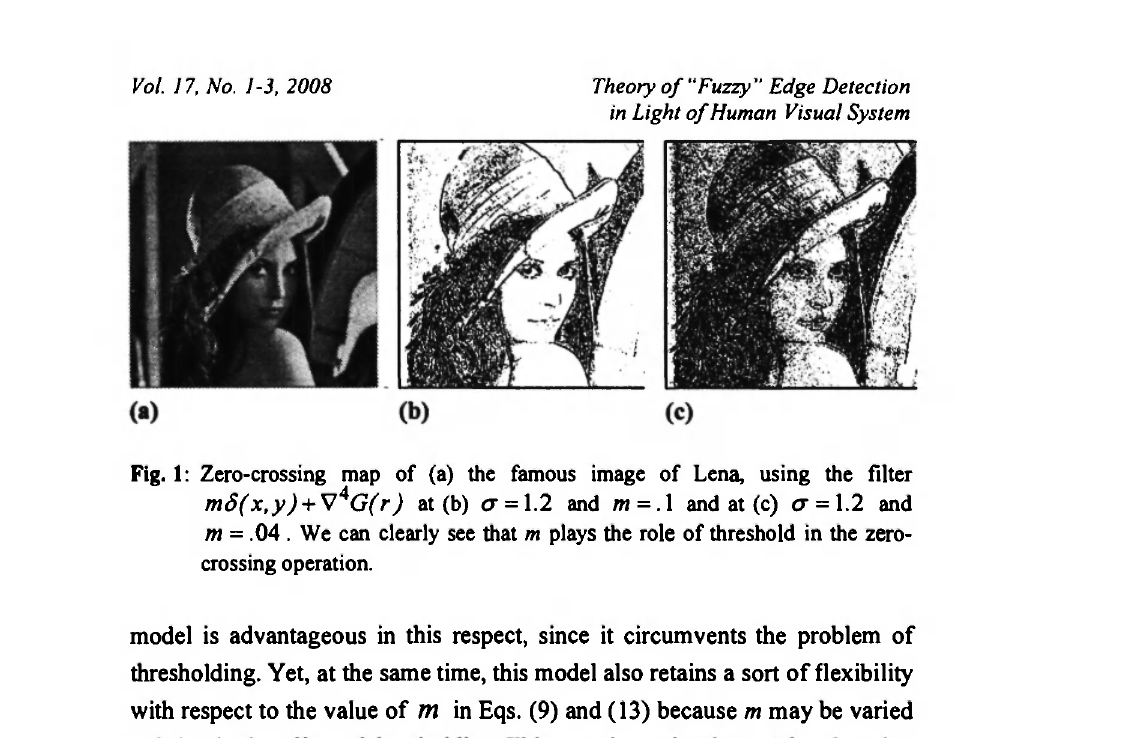
Fig. 1: Zero-crossing map of (a) the famous image of Lena, using the filter mS(x,y) + V 4 G(r) at (b) σ = 1.2 and m = . 1 and at (c) σ = 1.2 and m = .04 . We can clearly see that m plays the role of threshold in the zero- crossing